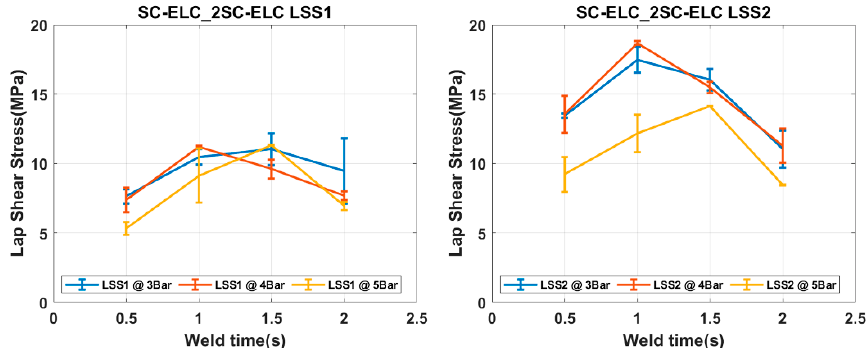
Materials 2018 , 11 , x FOR PEER REVIEW Figure 13. LSS1 and LSS2 graphs for SC-ELC_2SC-ELC configuration. Figure 13. LSS1 and LSS2 graphs for SC-ELC_2SC-ELC configuration.